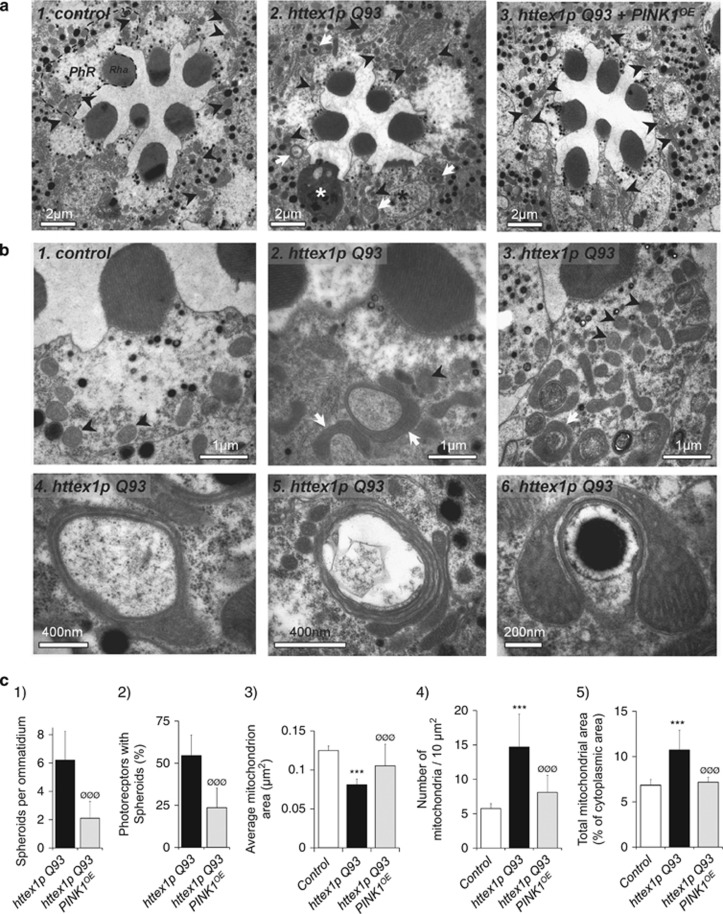
Mitochondrial spheroid formation precedes Httex1p Q93-induced neurodegeneration and is suppressed by Drosophila PINK1 overexpression. (a) Transmission electron microscopy (TEM) pictures of eye sections from 1-day-old adult Drosophila. Panel 1: Ommatidia of control flies normally contain seven visible photoreceptor neurons (PhRs), each photoreceptor harboring a rhabdomere membrane subdomain (Rha) that detects light. Black arrowheads show typical round-shaped mitochondria. Panel 2: Targeted neuronal expression of httex1p Q93 triggers rhabdomere degeneration (black asterisk) and photoreceptor apoptosis (white asterisk). Circular electron-dense structures corresponding to mitochondrial spheroids (white arrows) are observed in the cytoplasm of non-apoptotic PhRs. Black arrowheads point to round-shaped mitochondria. Panel 3: TEM picture of an ommatidium from 1-day-old Drosophila coexpressing httex1p Q93 and Drosophila PINK1 (PINK1OE) in neurons. No mitochondrial spheroid is detected in this ommatidium. Black arrows correspond to round-shaped mitochondria. (b) High magnification TEM images show that circular electron-dense structures observed in Httex1p Q93 photoreceptors are mitochondrial spheroids. Panels 1 and 2, respectively, show control and Httex1p Q93-expressing photoreceptors with no sign of degeneration. Black arrowheads point to mitochondria with normal round-shaped morphology, whereas white arrows correspond to spheroid mitochondria. Panel 3 represents an httex1p Q93-expressing photoreceptor containing a massive accumulation of mitochondria within its cytoplasm (white arrows: mitochondrial spheroids; black arrows: round-shaped mitochondria). Panels 4–6 show the ultrastructure of representative mitochondrial spheroids from httex1p Q93-expressing photoreceptors. Mitochondrial spheroids often form ring-like structures harboring an enlarged region. Mitochondrial spheroids can also appear as bended barbell-like structures (panels 5 and 6) sometimes involving multiple mitochondria (panel 5) or even enwrapping cytoplasmic components such as pigment granules (panel 6). (c) Quantitative analyses from 1-day-old flies expressing no transgene (control), httex1p Q93 alone or together with PINK1 (PINK1OE) in neurons. Histograms show the number of spheroids per ommatidium (histogram 1), the number of photoreceptors containing mitochondrial spheroids (histogram 2), the average area of individual mitochondria (μm2) (histogram 3), the number of mitochondria per 10 μm2 of the cytoplasm (histogram 4) and the total area occupied by the mitochondria within the photoreceptor cytoplasm (ratio of mitochondrial area/cytoplasmic area in %) (histogram 5). Measurements in histograms 3–5 do not include spheroids. Observations were made on eye sections from at least three independent flies. Spheroid quantifications were performed on 20 ommatidia and 120 non-apoptotic photoreceptors for httex1p Q93, and 32 ommatidia and 190 non-apoptotic photoreceptors for httex1p Q93+PINK1OE. Quantification of mitochondrial area, number and density were performed on 51 photoreceptors and 278 mitochondria for control, 55 photoreceptors and 875 mitochondria for httex1p Q93, and 58 photoreceptors and 374 mitochondria for httex1p Q93+PINK1OE. Statistics were performed by using the Mann–Whitney U-test (***P<0.0001 versus control; ØØØP<0.0001 versus
httex1p Q93)